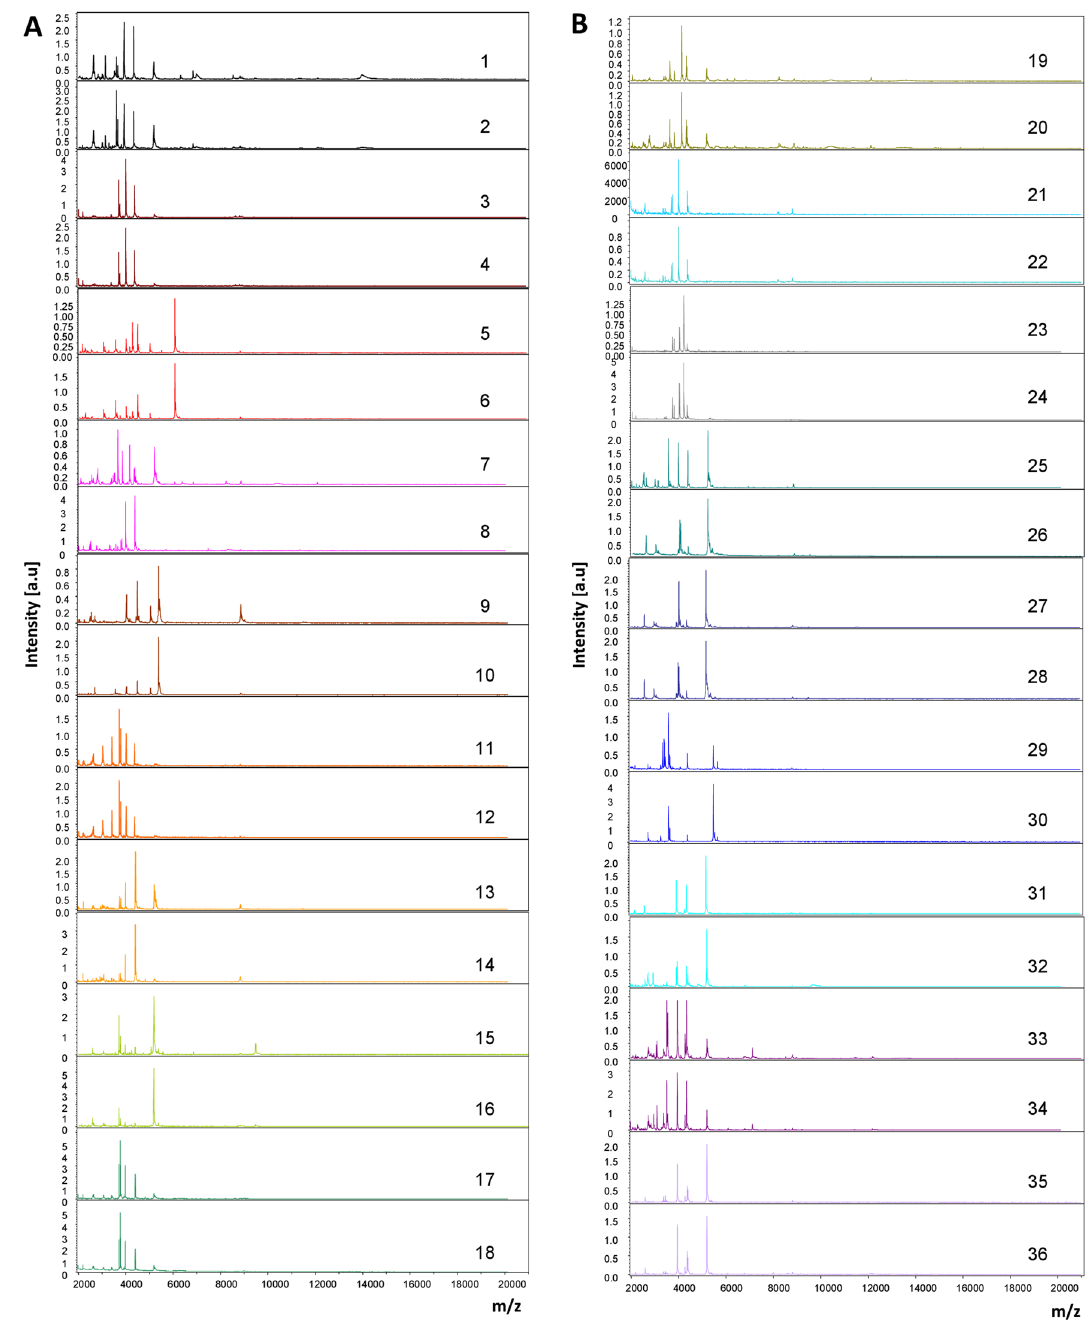
Figure 3. Representative MS profiles obtained for each termite species using the Flex analysis 3.3 software ( A ) and ( B ). ( A ) represents the spectra obtained from the leg protein of Ancistrotermes cavithorax (1–2), Amitermes evuncifer (3–4), Cubitermes orthognatus (5–6), Cryptotermes brevis (7–8), Kalotermes flavicollis (9–10), Macrotermes bellicosus (11–12), Macrotermes herus (13–14) , Macrotermes ivorensis (15–16), Macrotermes subhyalinus (17–18) and ( B ) the spectra from Microcerotermes parvus (19–20), Microtermes sp (21–22), Odontotermes latericius (23–24), Procubitermes sjostedti (25–26), Promirotermes holmgreni (27–28), ( Reticulitermes lucifugus (29–30), Trinervitermes geminatus (31–32), Trinervitermes occidentalis (33–34), Trinervitermes trinervius (35–36). a.u.: arbitrary units; m/z: mass-to-charge